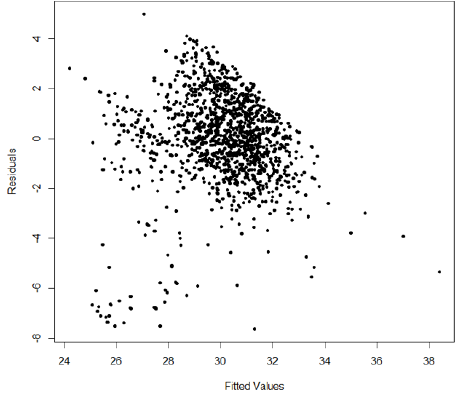
Figure 5. Residuals vs Fitted Values.